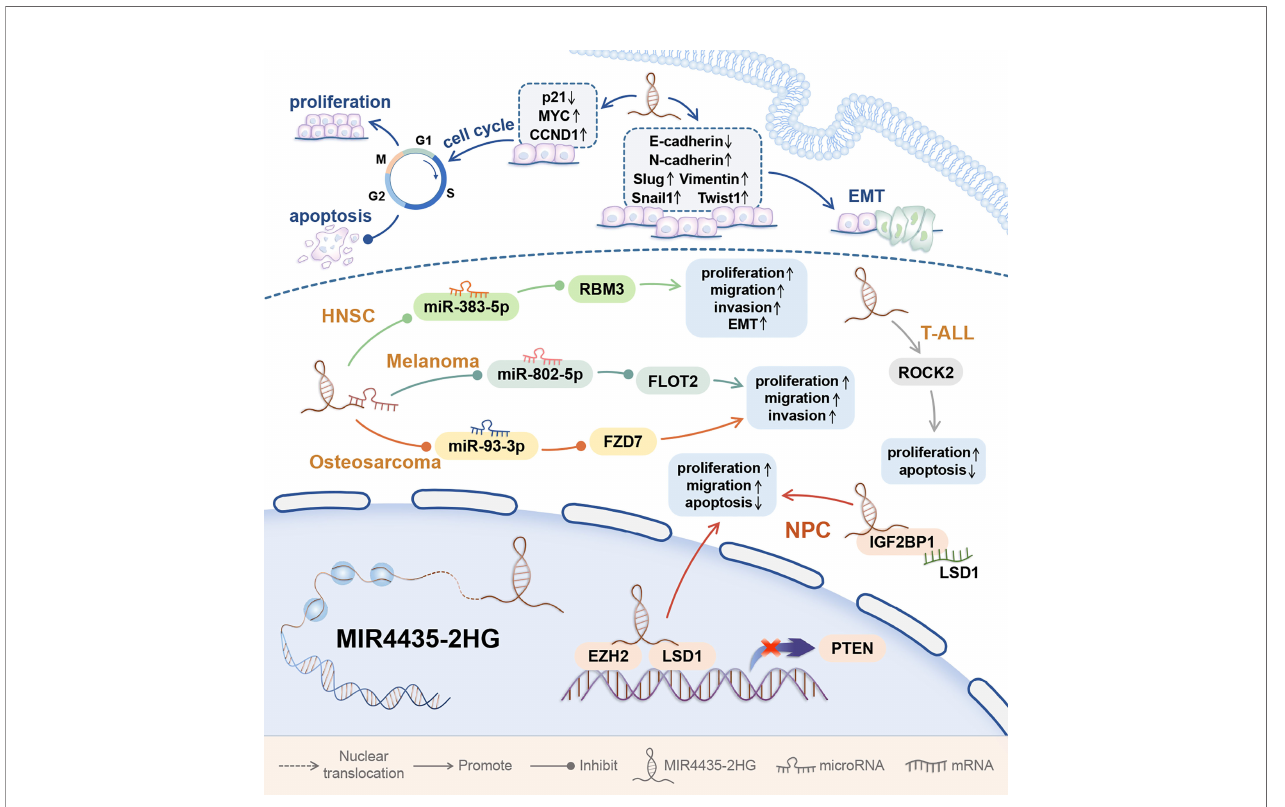
FIGURE 4 | The mechanism of MIR4435-2HG affecting the behavior of tumor cells in other Systems. MIR4435-2HG can promote the progression of tumors in other systems, and affect the proliferation, invasion, migration, apoptosis, and EMT of tumor cells. Affecting EMT and cell cycle is an important mechanism for MIR4435- 2HG to promote tumorigenesis. Head and neck squamous cell carcinoma (HNSC); T-cell acute lymphoblastic leukemia (T-ALL); nasopharyngeal carcinoma